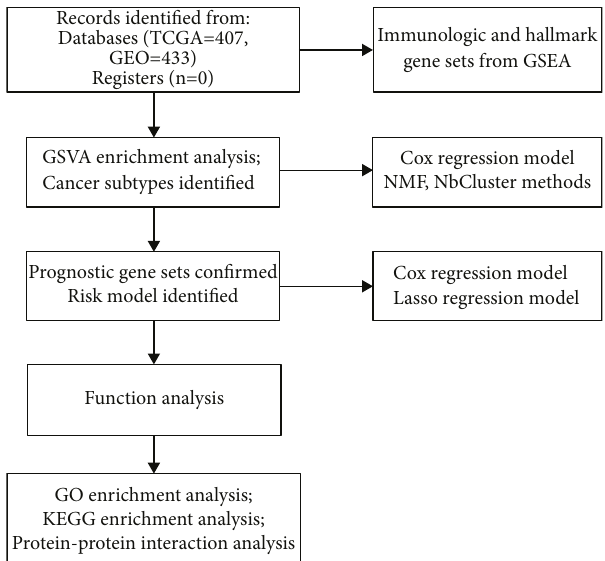
Figure 1: Flow diagram of the